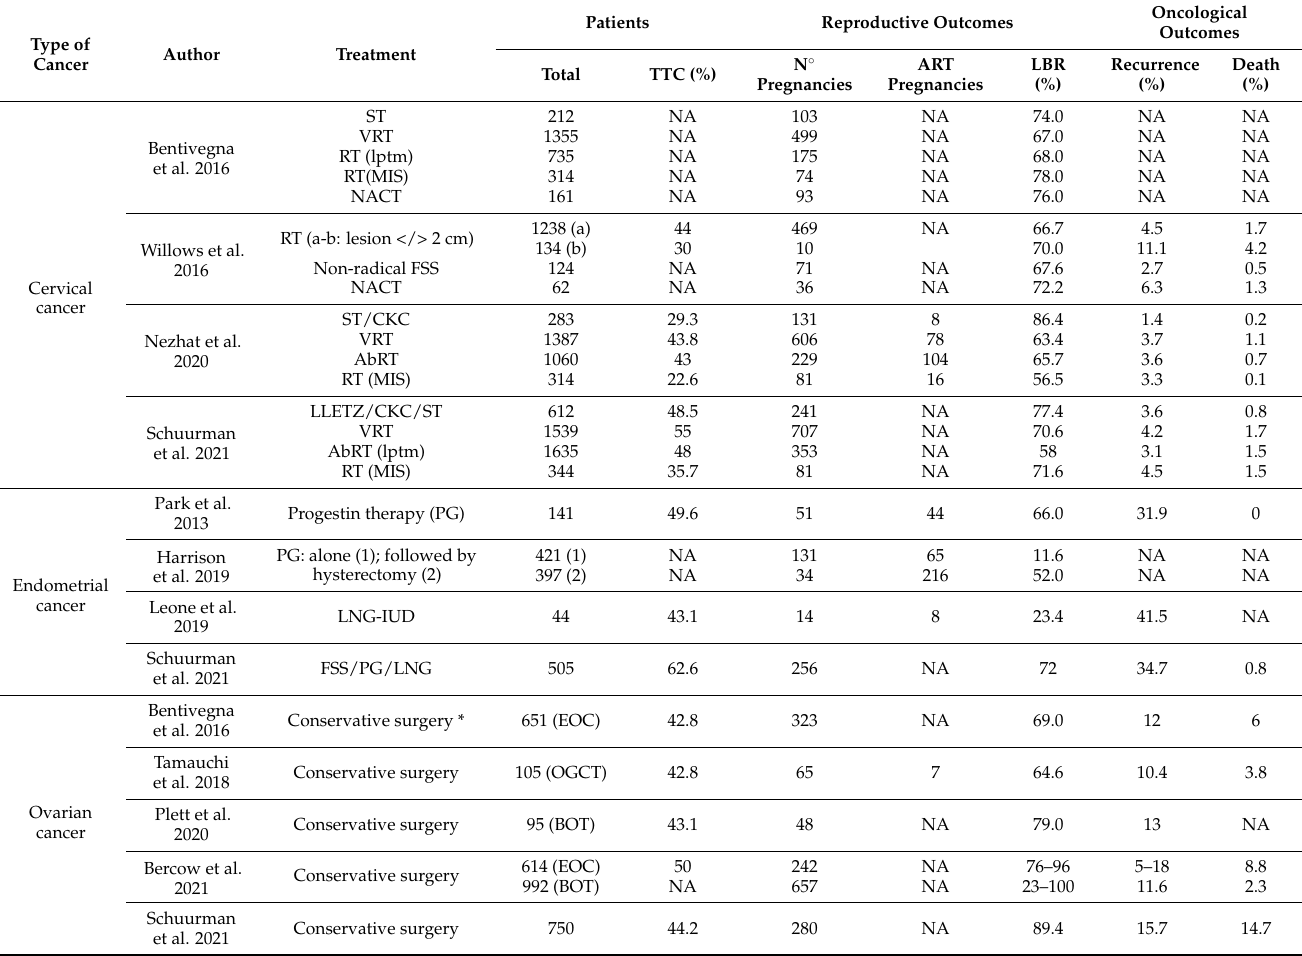
Table 3. Reproductive and oncological outcomes of patients after undergoing fertility-sparing surgical